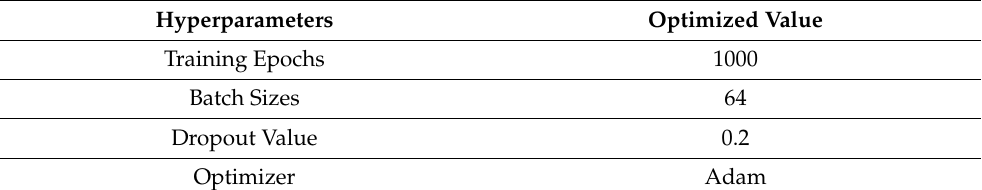
Table 2. Optimized hyperparameters values of the Conv-3 DCNN.